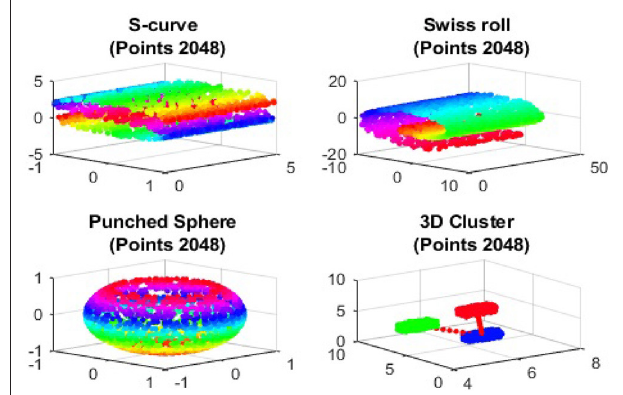
FIGURE 1 | S-curve, Swiss Roll, Punched Sphere, and